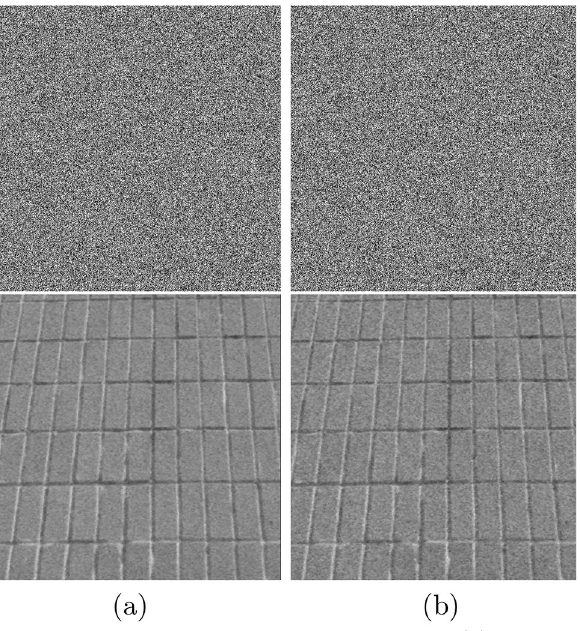
Figure 16. Encrypted and decrypted images for noise attack. ( a ) Salt and pepper noise of intensity 0.05. ( b ) Salt and pepper noise of intensity 0.1.